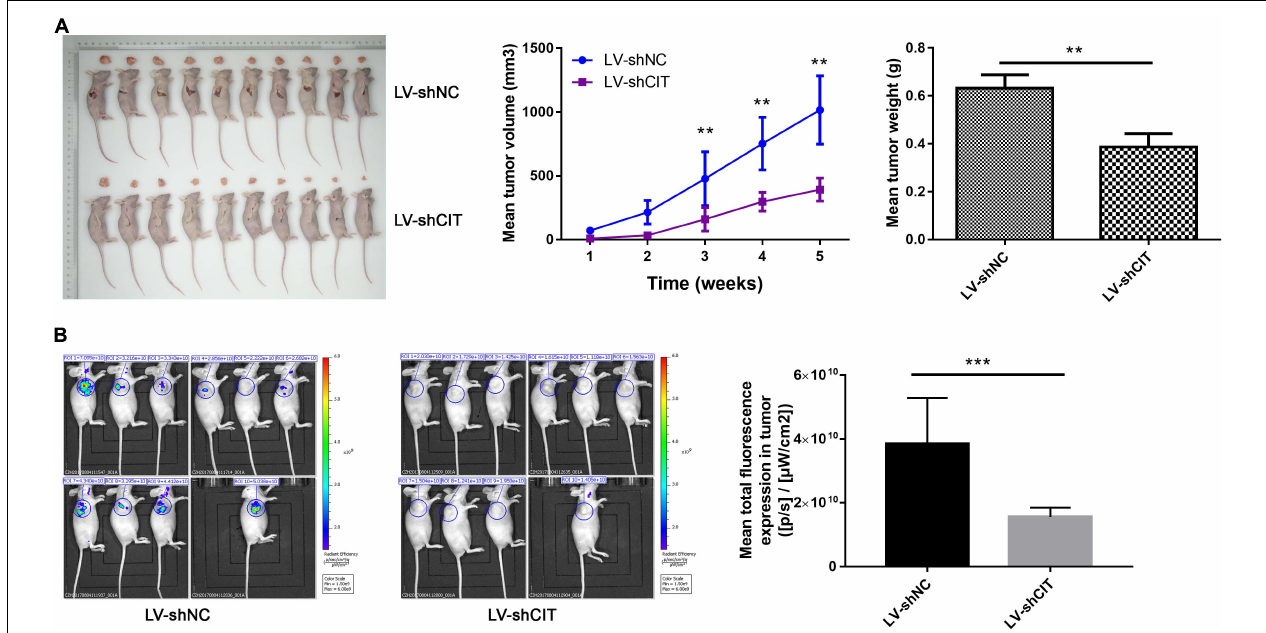
FIGURE 3 | Effects of CIT knockdown on tumor growth in vivo . (A) Changes in tumor volume and tumor weight in nude mice with LV-shCIT or LV-shNC xenografts. Tumor was smaller in LV-shCIT nude mice than that in LV-shNC mice. (B) Tumor fluorescence imaging of the two groups of nude mice (left). Mean total fluorescence expression in tumors of nude mice in LV-shCIT or LV-shNC groups(right); fluorescence intensity was significantly higher in nude mice in LV-shCIT group than that in LV-shNC group. ** P < 0.01 and *** P <